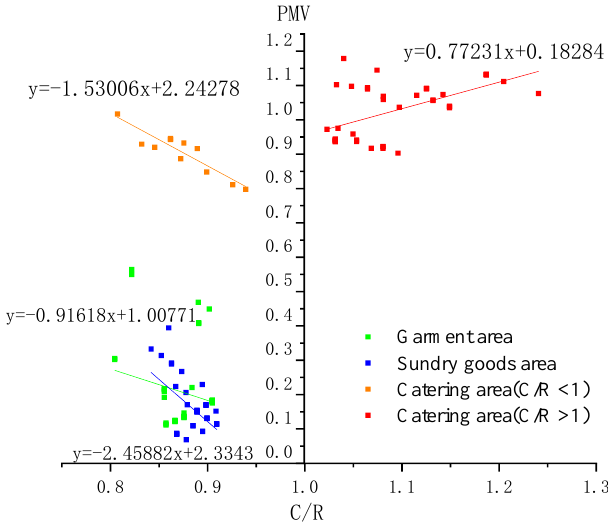
Figure 17. The relationship between C/R and PMV.